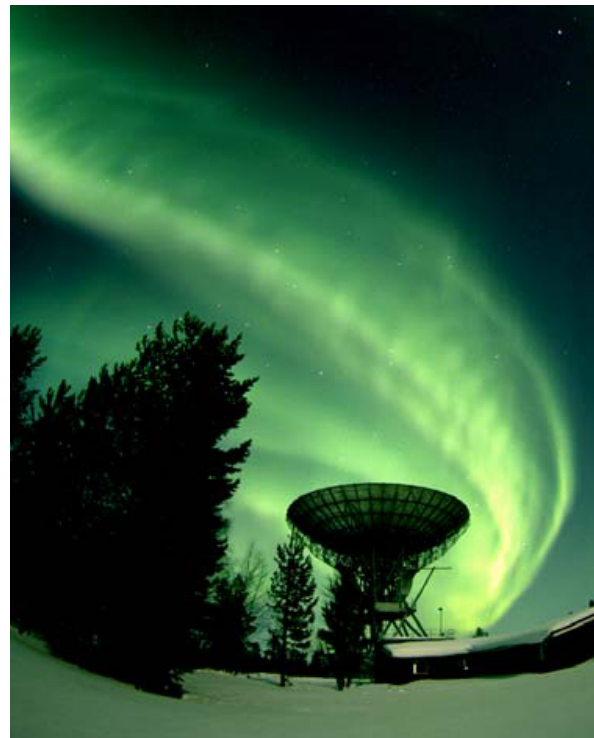
Figure 4. To give an impression of the site, where the inauguration